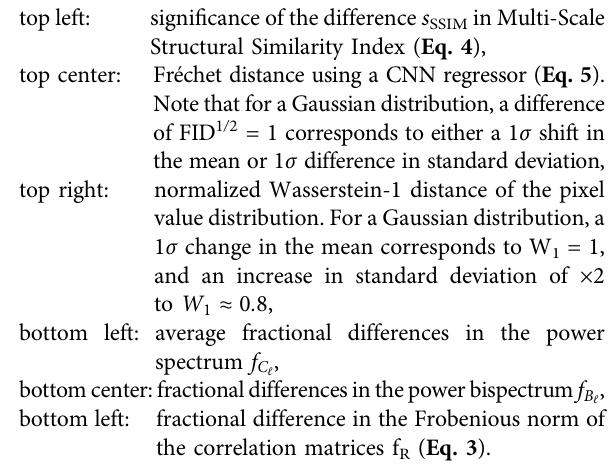
FIGURE 4 | Images generated with the same random seed but with different input cosmology parameters Ω m and σ 8